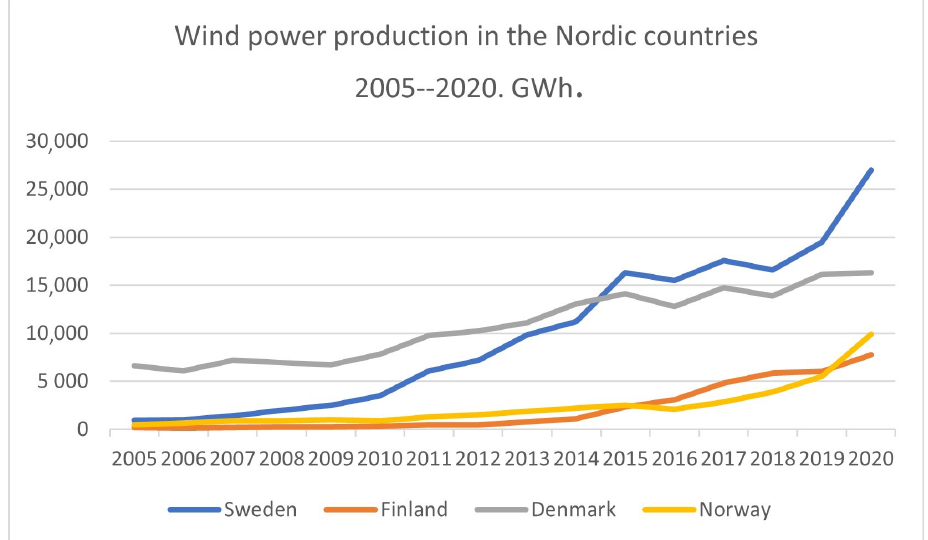
Figure 12. The wind power production in the four Nordic countries in 2005–2020. Measured in GWh.